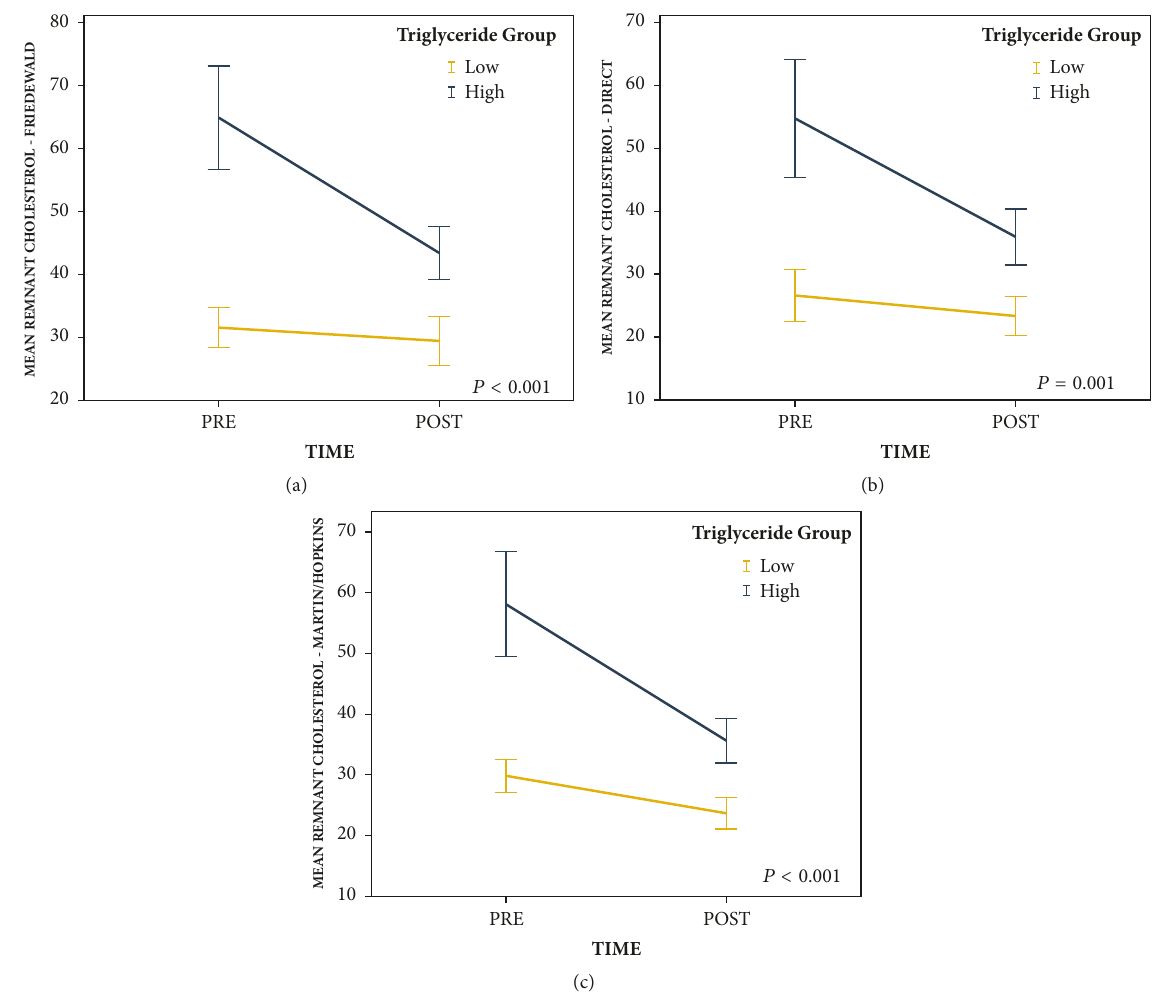
Figure 1: Change in remnant cholesterol levels from pretreatment to posttreatment by pretreatment triglyceride groups (error bars: 95%